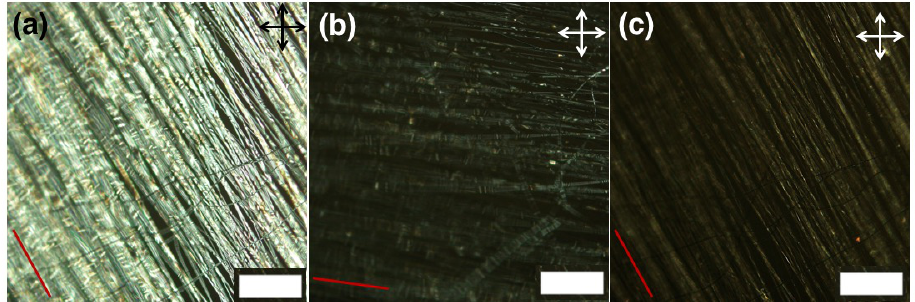
Figure 2. POM of LCE-PVP fibers spun aligned on glass (polymerized at 55 ◦ C ), ( a ) between crossed polarizer and analyzer, with average fiber orientation (red line) roughly at 45 ◦ to the polarizer and ( b ) roughly parallel to the polarizer; In ( c ) the fibers have the original orientation, as in ( a ), but they are heated to 72.5 ◦ C, at which the core turns isotropic, leading to strong reduction in birefringence. The red line represents the average fiber orientation of fibers. (scale bars: 200 µ m).